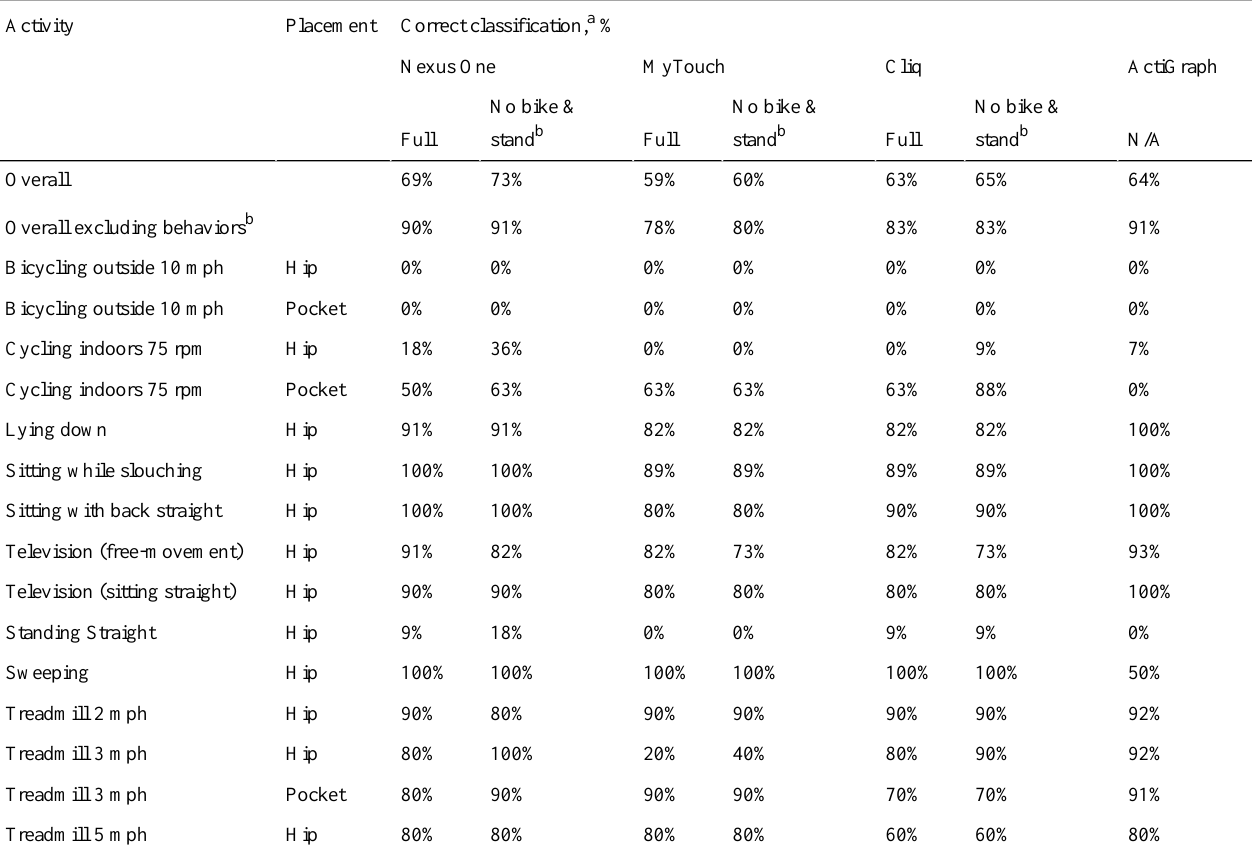
Table 3. Correct classification of activity intensity level for each device. Correct classification, a